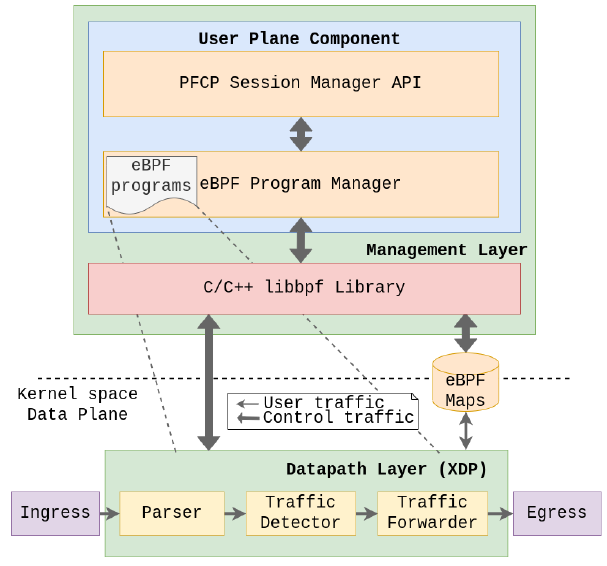
Figure 8. High level design of the user plane library using BPF/XDP.